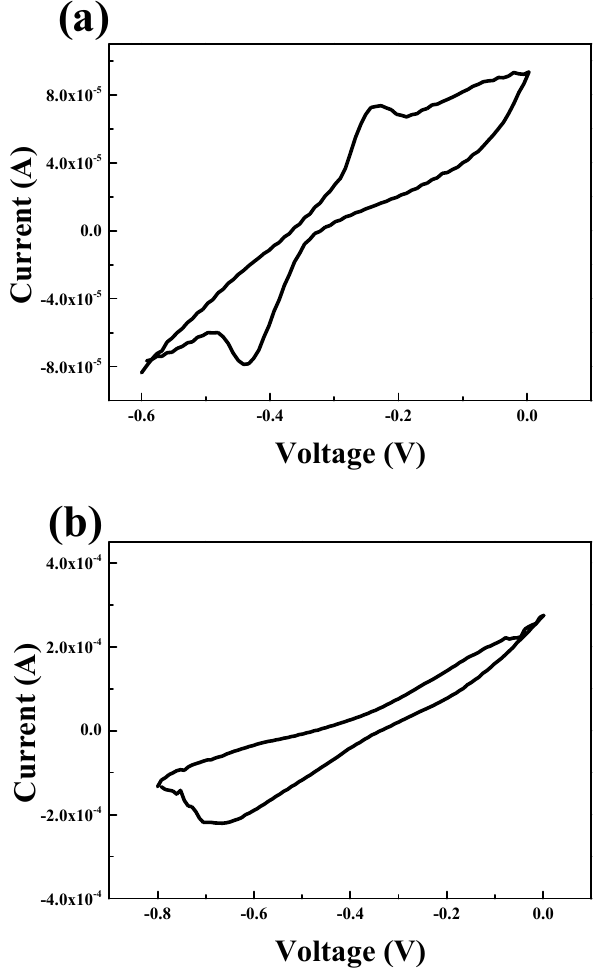
Figure 7. CV 2 of the ZnO NS on which the H 2 reduction process was performed for 5 min ( a ) and 10 min ( b ).